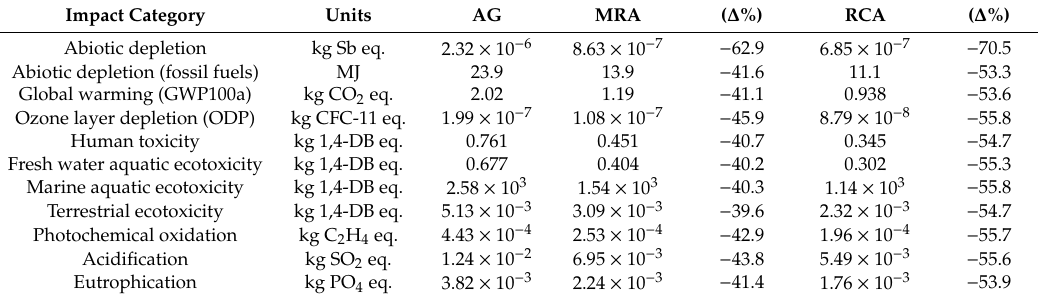
Table 11. Characterization results of AG, RCA, and MRA (per 1